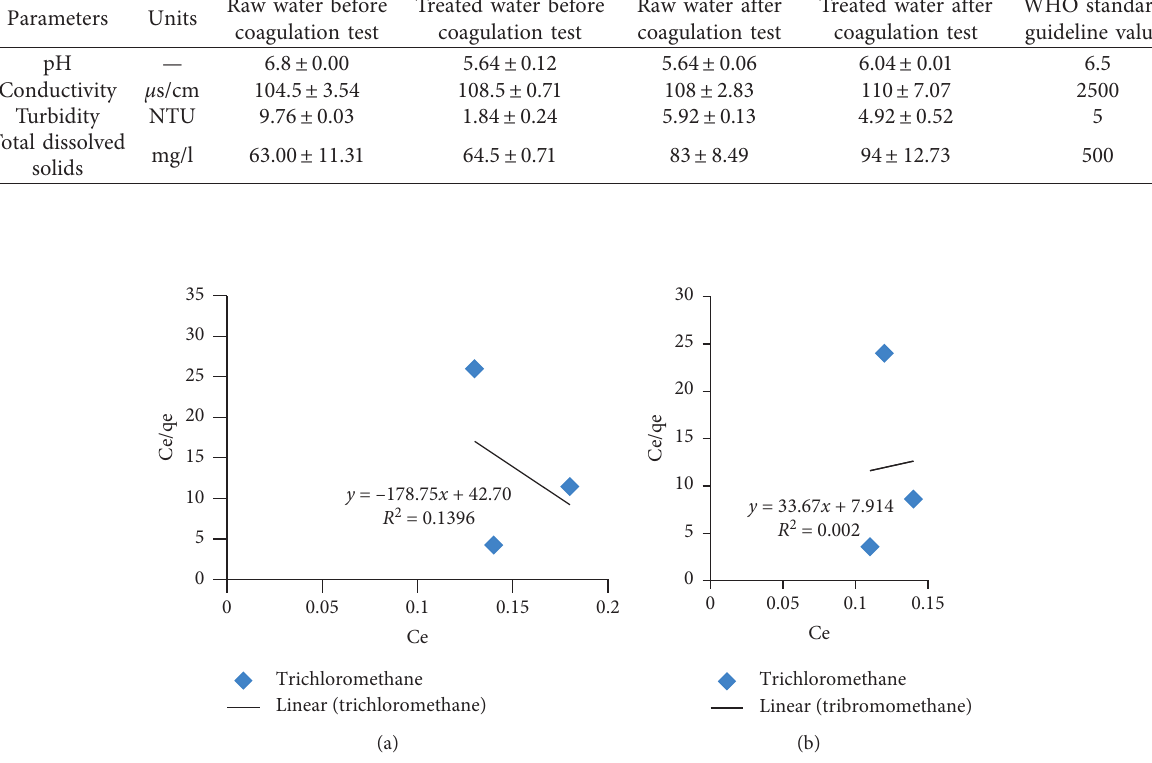
Figure 7: Langmuir adsorption isotherms for the adsorption of (a) trichloromethane and (b) tribromomethane using Moringa oleifera seed husk activated carbon.